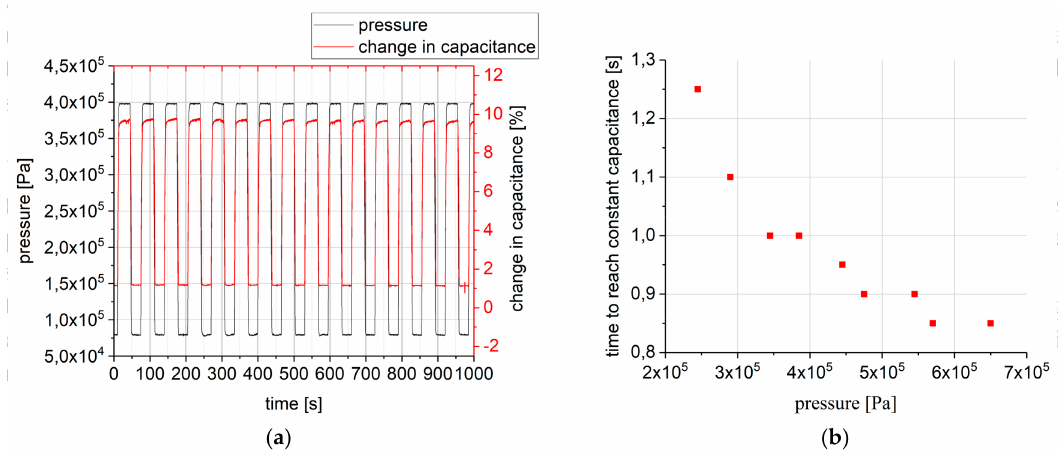
Figure 3. ( a ) The applied pressure (black) and the change in capacitance (red) as a function of time; ( b ) The time the sensor the sensor takes to reach a level of constant capacitance after a pressure has been applied as a function of final pressure level. The initial pressure was 50 kPa for each measurement.